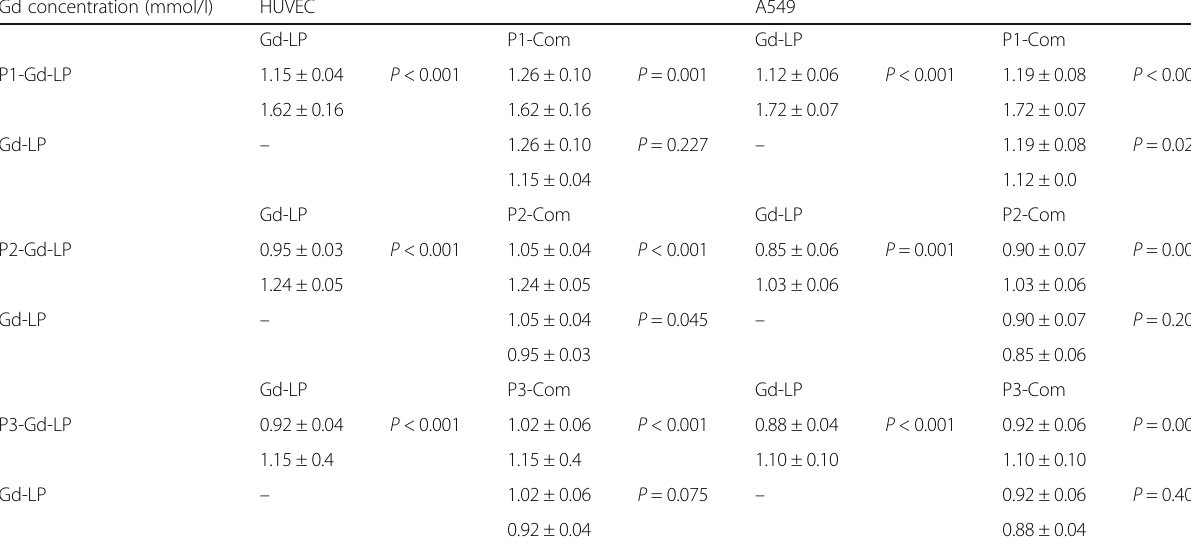
Table 1 Cellular competition study of P1-Gd-LP, P2-Gd-LP, and P3-Gd-LP, with P1, P2, and P3 respectively added to inhibit receptors in the competition groups. The data of all experiments were expressed by the mean ± standard deviation ( n = 5) Gd concentration (mmol/l)